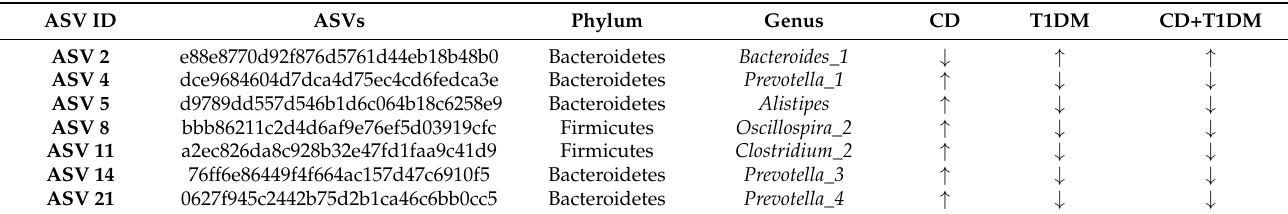
Table 3. Differentially abundant ASVs that were common among the three diseased groups (CD, T1DM, T1DM+CD) compared to healthy controls. ↑ (increased abundance relative to healthy control) ↓ (decreased abundance relative to healthy control). Abbreviations: T1DM = Type 1 Diabetes; CD = Coeliac disease; ASV = Amplicon sequence